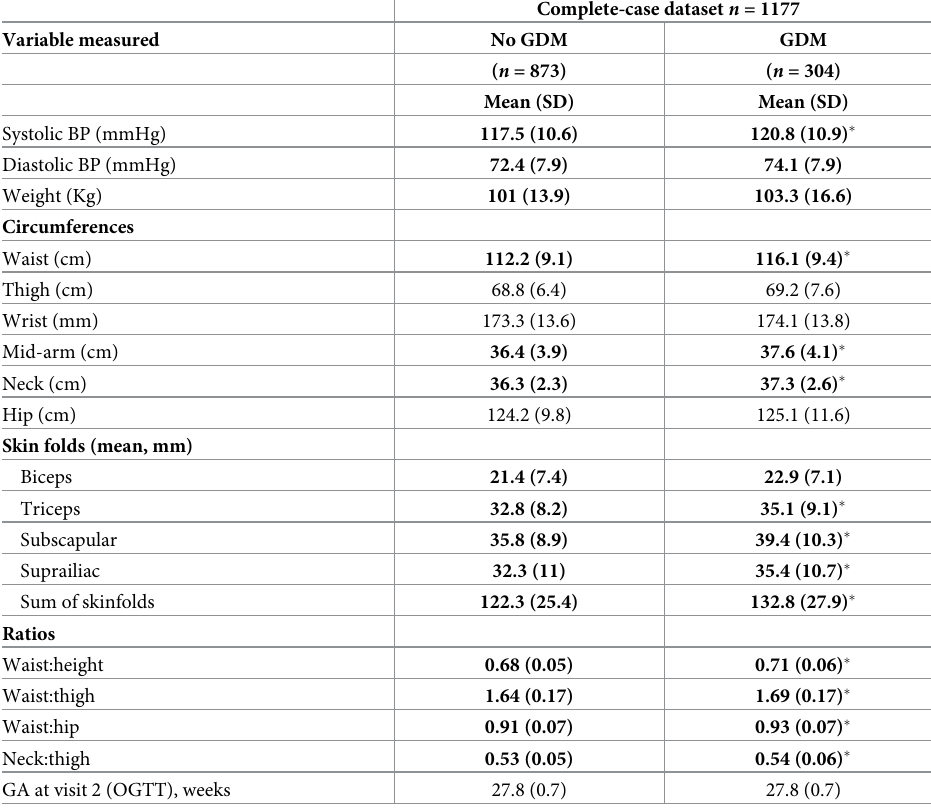
Table 3. Maternal clinical and anthropometric measures in early third trimester (mean 27 +5 weeks’ gestation) by GDM status diagnosed at same